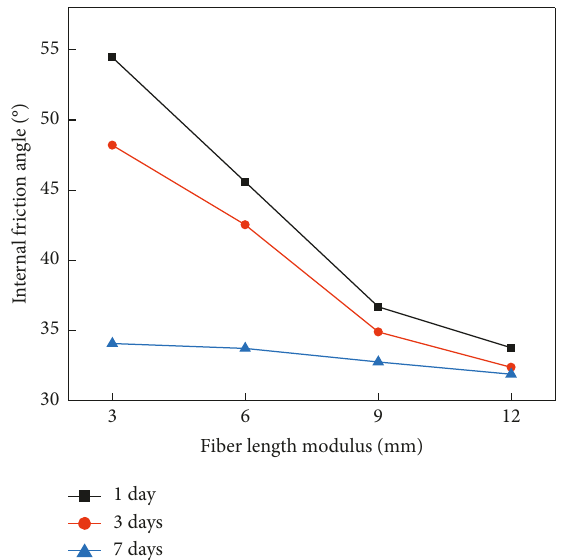
Figure 8: Variation of the number of vibrations of consolidated remolded soils with fiber content at different conservation